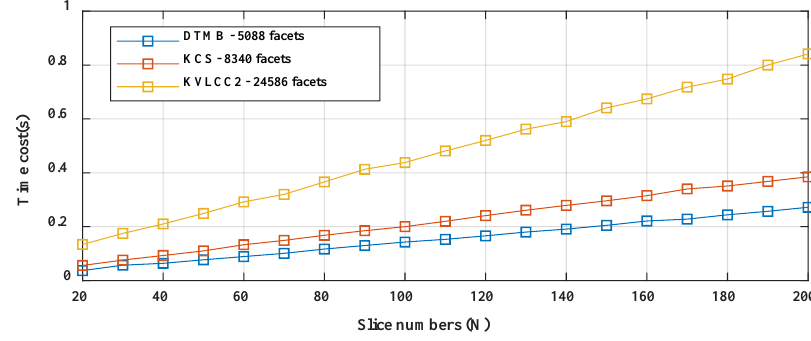
Figure 16. Computational costs.